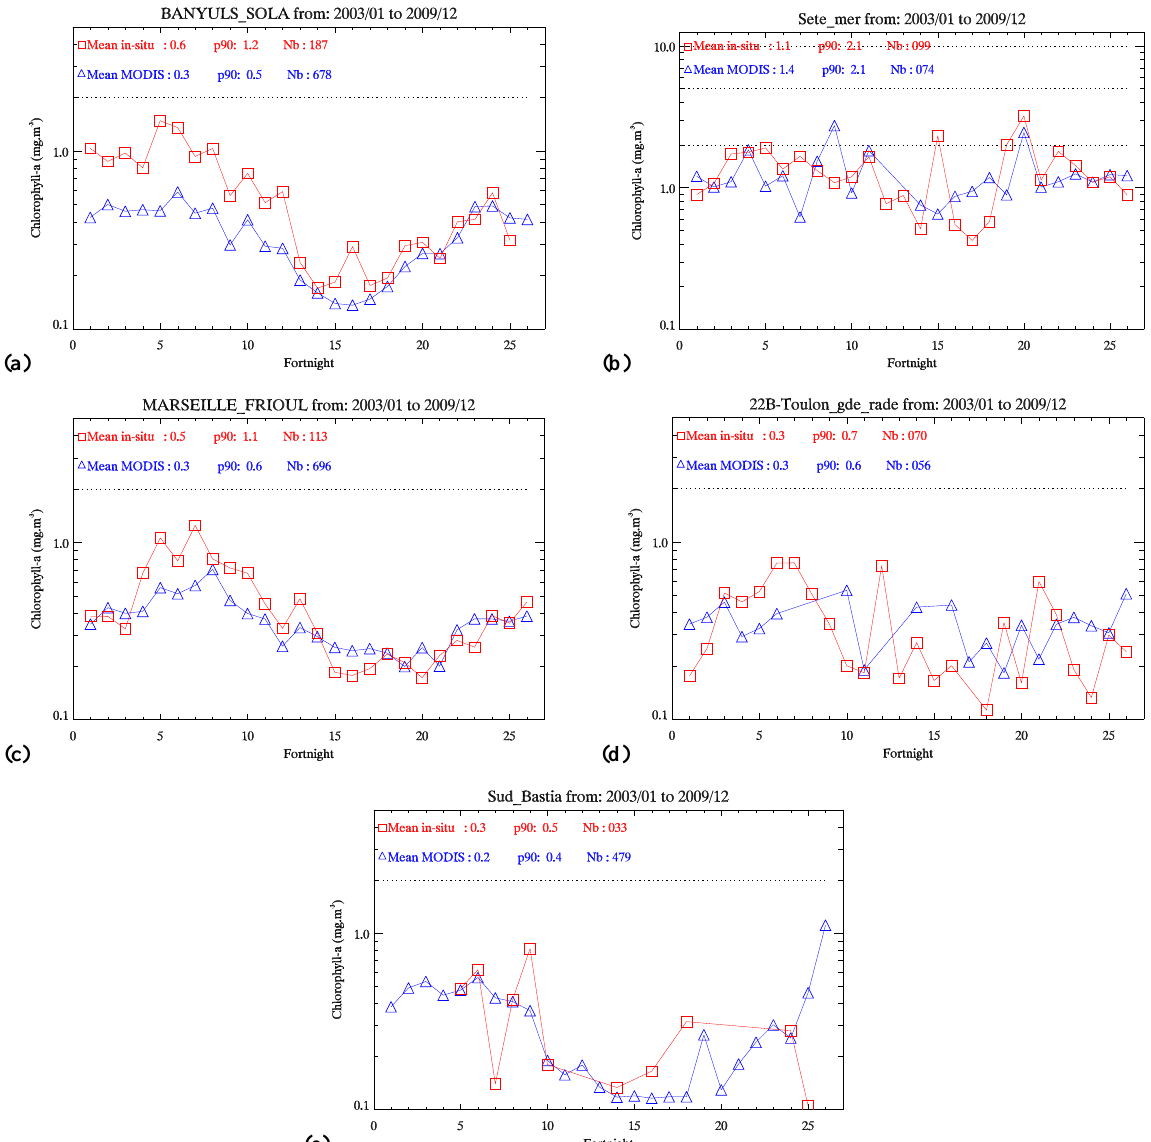
Fig. 5. The annual cycles of Chl at the selected stations of the Mediterranean